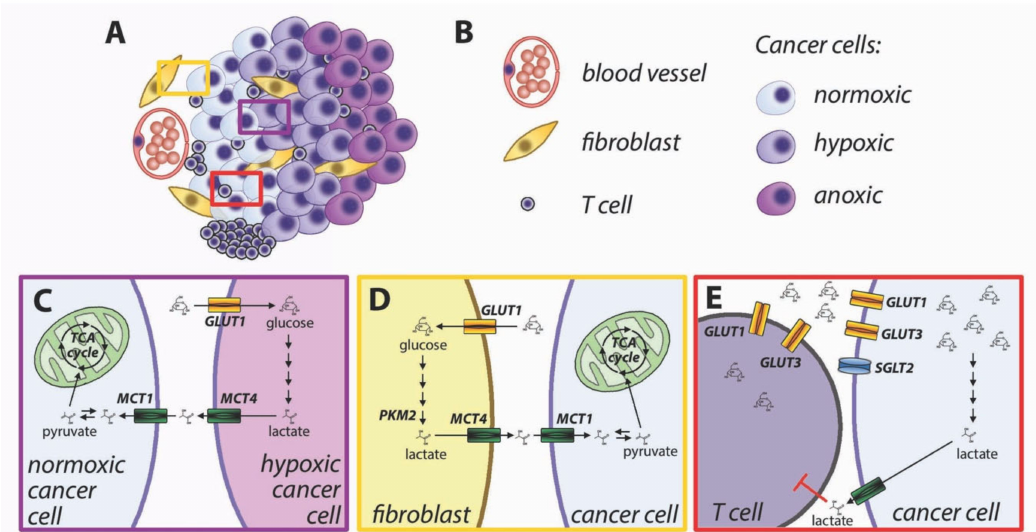
Figure 4. Metabolic interactions in the tumor microenvironment. ( A ) Schematic representation of the tumor microenvironment; ( B ) Description of the di ff erent cell types presented in (A); ( C – E ) Color-coded higher magnifications of the rectangles presented in (A), highlighting metabolic interactions in the tumor microenvironment. ( C ) lactate-fueled respiration, ( D ) reverse Warburg e ff ect and ( E ) immune metabolic